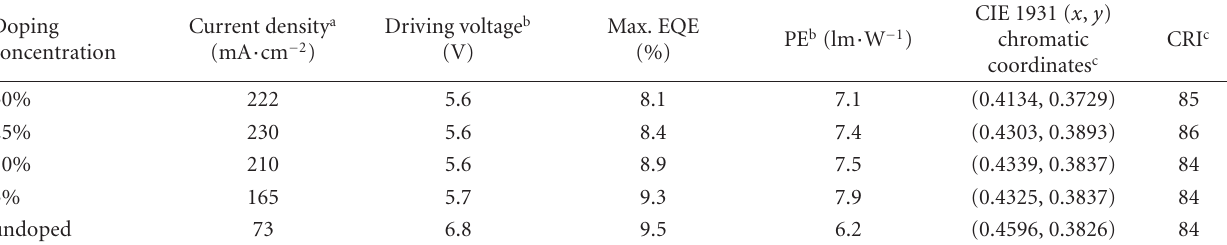
Table 1: Performance of the WOLEDs with di ff erent MoO 3 doping